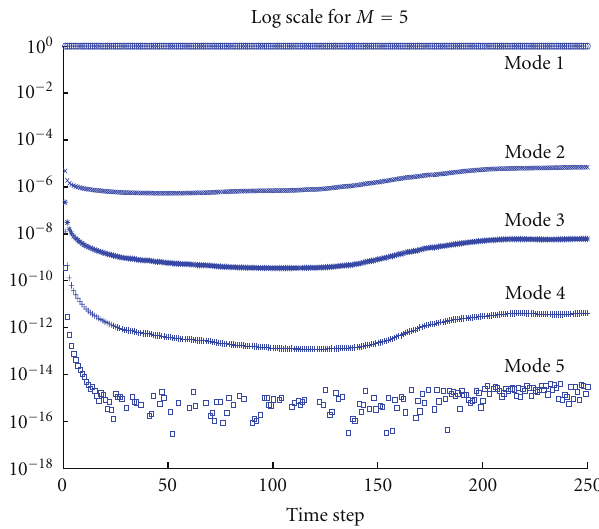
Figure 12: Normalized energy versus convective time (projective time step) in transient case, Re =